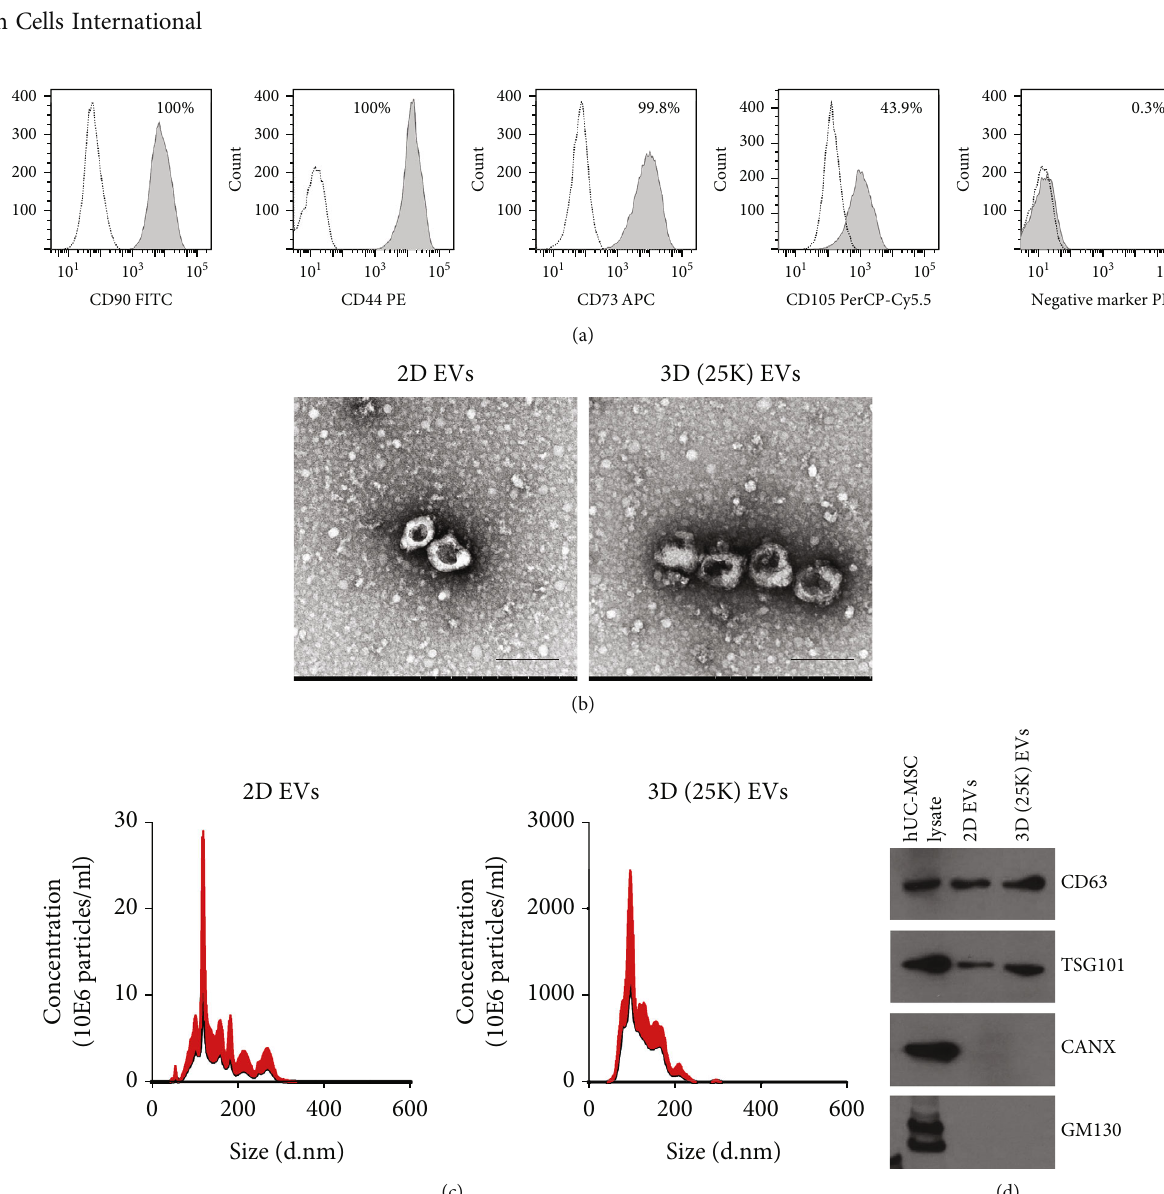
Figure 1: Characterization of 2D and 3D hUCB-MSC-derived extracellular vesicles (EVs). (a) MSC markers, CD90, CD73, CD44, and CD105, and MSC negative markers were analyzed by fl ow cytometry. The white curve represents the isotype control, and the light gray curve represents stained cells. (b) 2D and 3D hUCB-MSCB-derived EVs were analyzed by transmission electron microscopy (TEM). Scale bar = 200nm . (c) The size distribution of 2D and 3D hUCB-MSC-derived EVs were analyzed by nanoparticle tracking analysis (NTA). (d) EV markers CD63 and TSG101 were identi fi ed by western